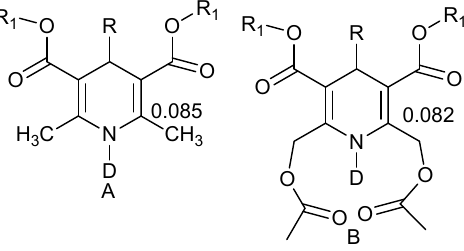
Figure 11. Two-bond deuterium isotope effects on 13 C chemical shifts of 1,4-dihydropyridines. ( A ) Without intra-molecualr hydrogen bond; ( B ) with intramolecular hydrogen bond From Ref. [30].